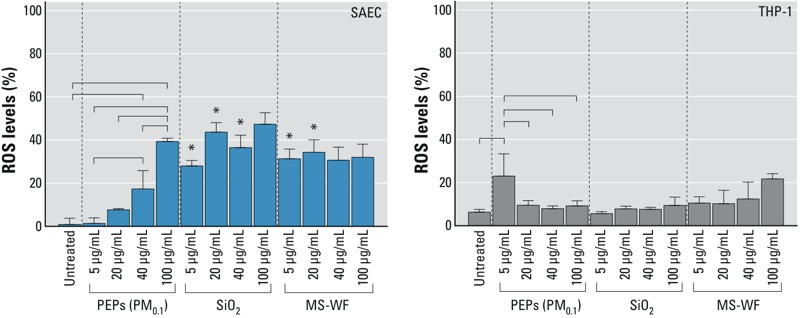
Percent increase of reactive oxygen species compared with that in untreated control cells; measured in supernatant from SAECs and THP-1 cells following a 24-hr exposure to PEPs (PM0.1), SiO2, and MS-WF. All values are represented as the mean ± SE. *Significantly different (p < 0.05) from PEPs (PM0.1), dose-matched treatment group. Bar represents a significant difference in measurements across the treatment groups with p < 0.05.